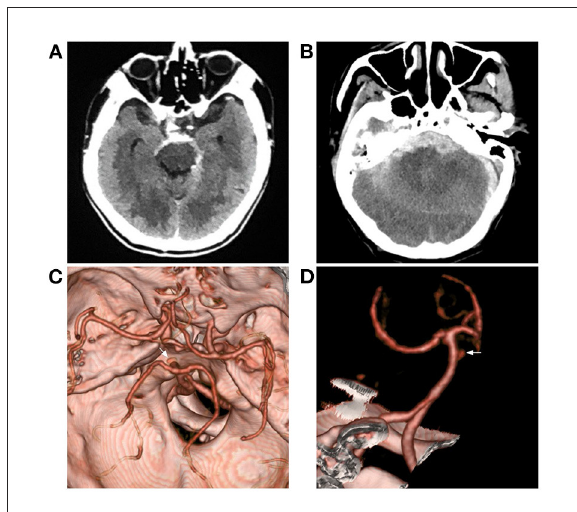
FIGURE2 Aneurysmal SAH with perimesencephalic bleeding pattern. (A) Immediate CT of the onset showing SAH with typical perimesencephalic bleeding pattern. (B) Repeated CT 6h after the onset showing a second SAH with the thick hemorrhage in front of the brainstem. (C,D) CTA showing an aneurysm of the basilar artery (arrows). CT, computed tomography; CTA, computed tomography angiography; SAH, subarachnoid hemorrhage.